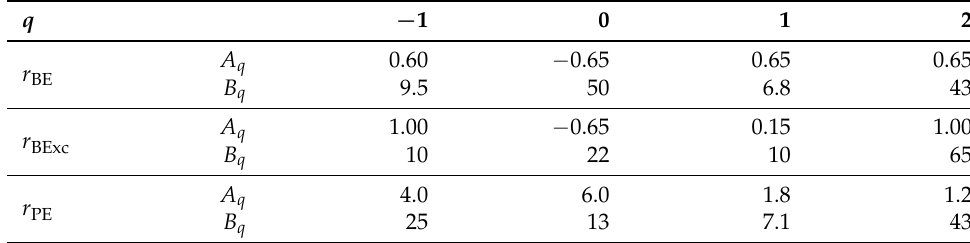
Table 4. Dual-band fit